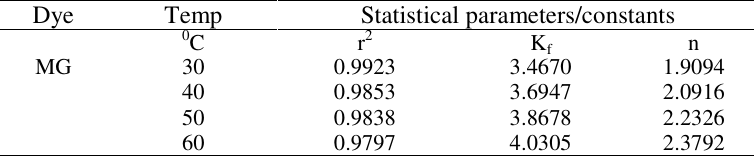
Table 4. Freundlich isotherm results